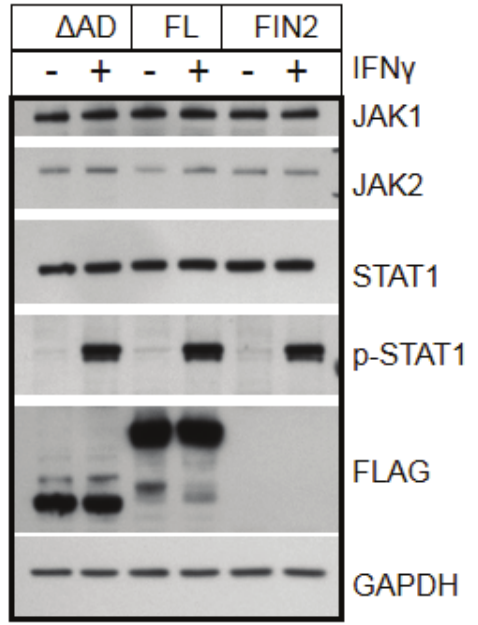
Figure 4. IE1 does not alter the state or abundance of key signaling molecules of the IFN γ pathway. Film images of electrophoretically separated cell lysates reacted with antibodies to IFN γ pathway signaling components. MRC5 cells were nucleofected with plasmid harboring full length IE1 (FL), the Δ 345–491 C-terminal truncation IE1 ( Δ AD) or empty vector (FIN2). At 24 hours after nucleofection, cells were exposed to IFN γ for 30 minutes or left untreated. Cells were solublized and equal amounts of protein from each lysate were subjected to electrophoresis in a denaturing polyacrylamide gel. Proteins were transferred to nitrocellulose sheets and reacted with the indicated antibodies. Anti-FLAG antibody was used to detect the presence of FLAG tagged IE1 proteins and antibody to GAPDH was used to evaluate protein